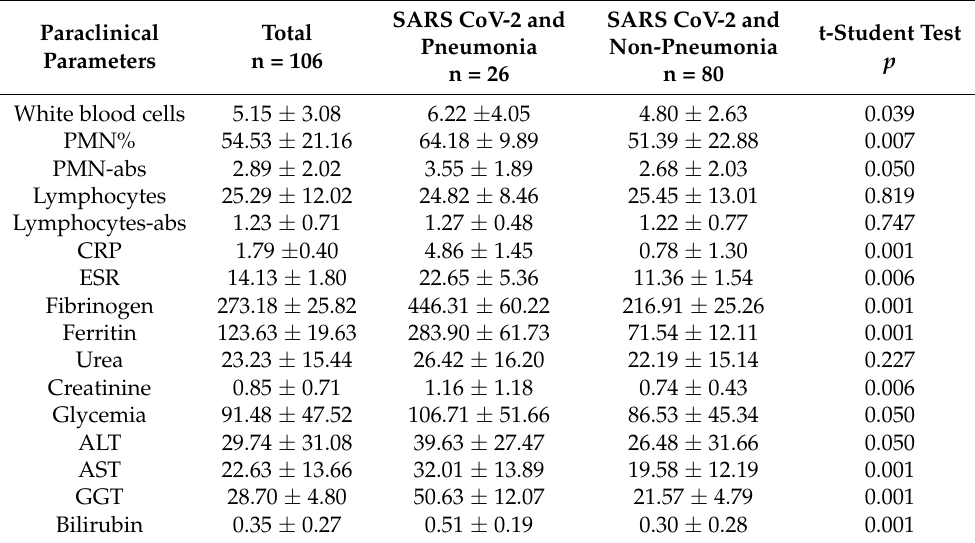
Abbreviations: SARS CoV-2, Severe Acute Respiratory Syndrome-Corona Virus-2; PMN, polymorphonuclear cells; CRP, C reactive protein; ESR, erythrocyte sedimentation rate; AST, aspartate aminotransferase; ALT, alanine aminotransferase; GGT, gamma-glutamyl